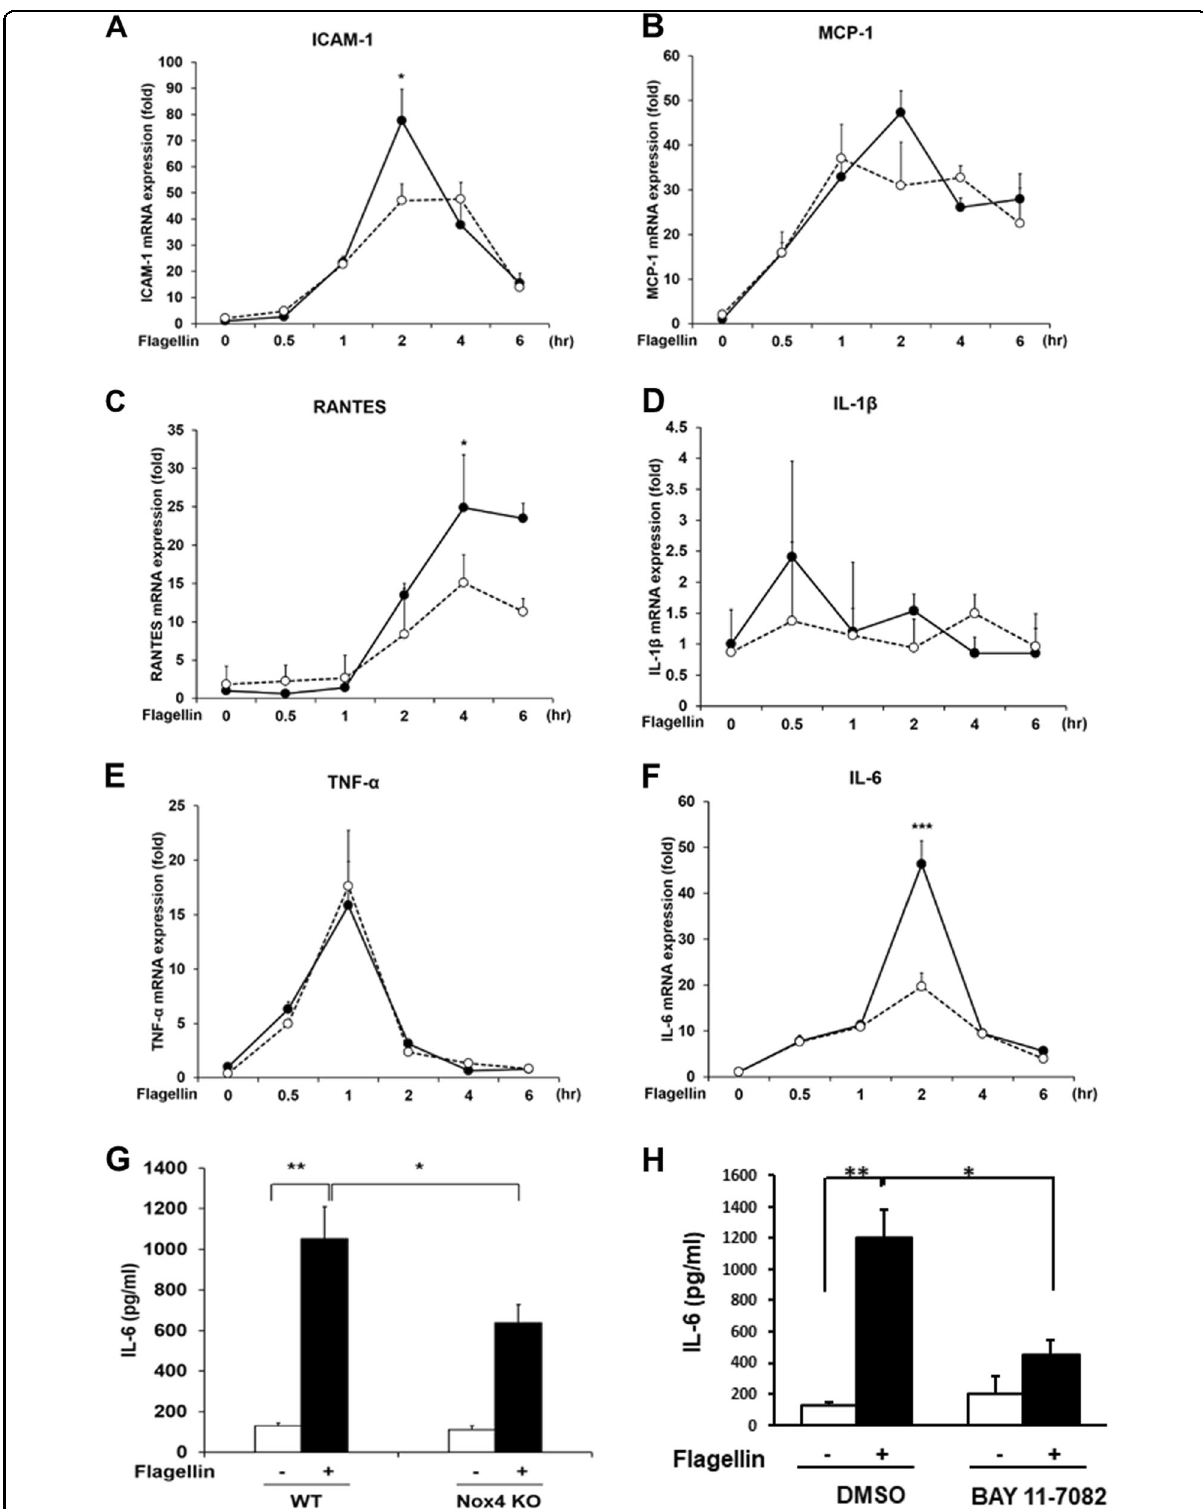
Fig. 3 (See legend on next